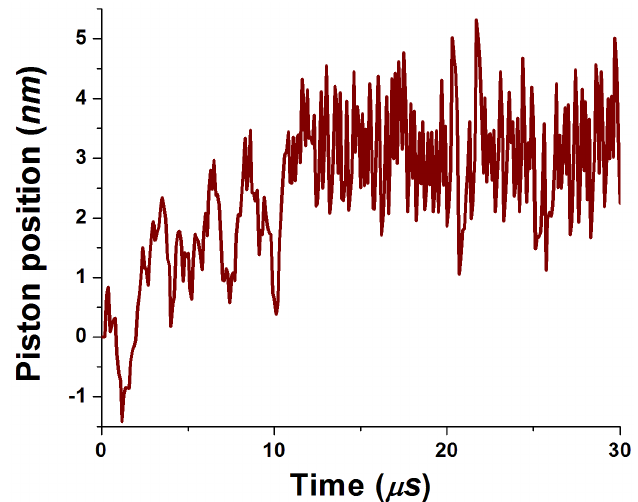
Figure 3. Time dependence of the piston position.